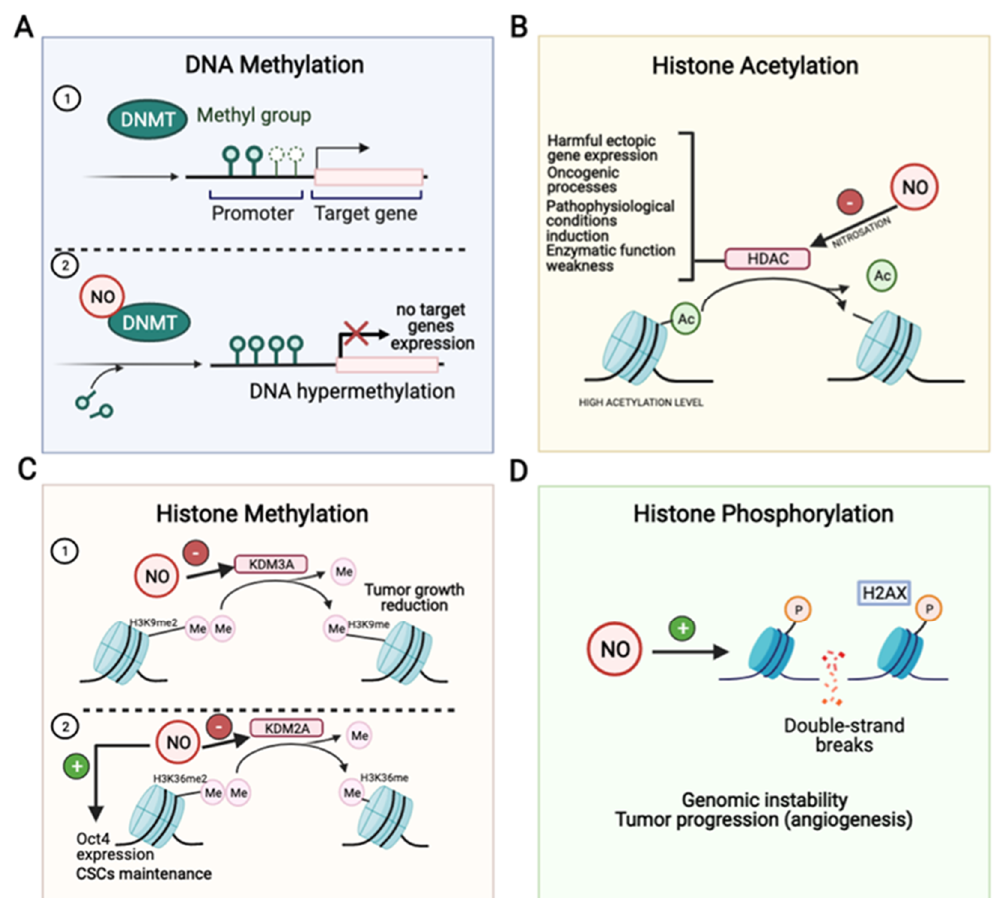
Figure 2. Impact of NO in DNA methylation ( A ), histone methylation ( B ), histone acetylation ( C ) and histone phosphorylation ( D ). DNA methyltransferases (DNMT) enzymes are responsible for methylating DNA cytosine residues. Genes with low promoter cytosine methylation are expressed ( A1 ), but upregulation of DNMT protein expression and activity by NO leads to increased DNA methylation at promoter regions and repression of downstream associated targets ( A2 ). NO inhibits histone deacetylases (HDAC) by S-nitrosation increasing acetylation level causing harmful ectopic gene expression, oncogenic processes, pathophysiological conditions induction and enzymatic function weakness ( B ). NO inhibits H3K9me2 lysine demethylase 3A (KDM3A) leading to decreased histone methylation status and tumor growth ( C1 ). Nonetheless, NO promotes Oct4 expression and CSCs maintenance through inhibiting H3K36me2 demethylase KDM2A ( C2 ). NO induces genomic DNA double-strand breaks and tumor progression ( D ). Acetylation, Ac; lysine demethylase 2A, KDM2A; methylation, Me; phosphorylation, P.